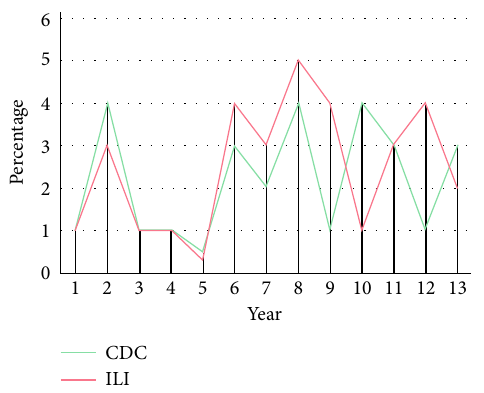
Figure 3: Model comparison